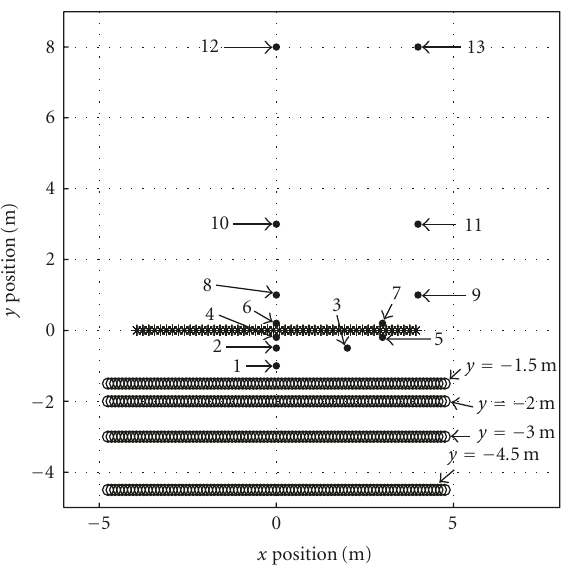
Figure 11: Top view of the considered system: 48 regularly spaced (16.75 cm) loudspeakers ( ∗ ) measured on 4 depths ( y = − 1 . 5, − 2, − 3, − 4 . 5 m) with 96 regularly spaced (10cm) micro- phones (circle) reproducing 13 test sources